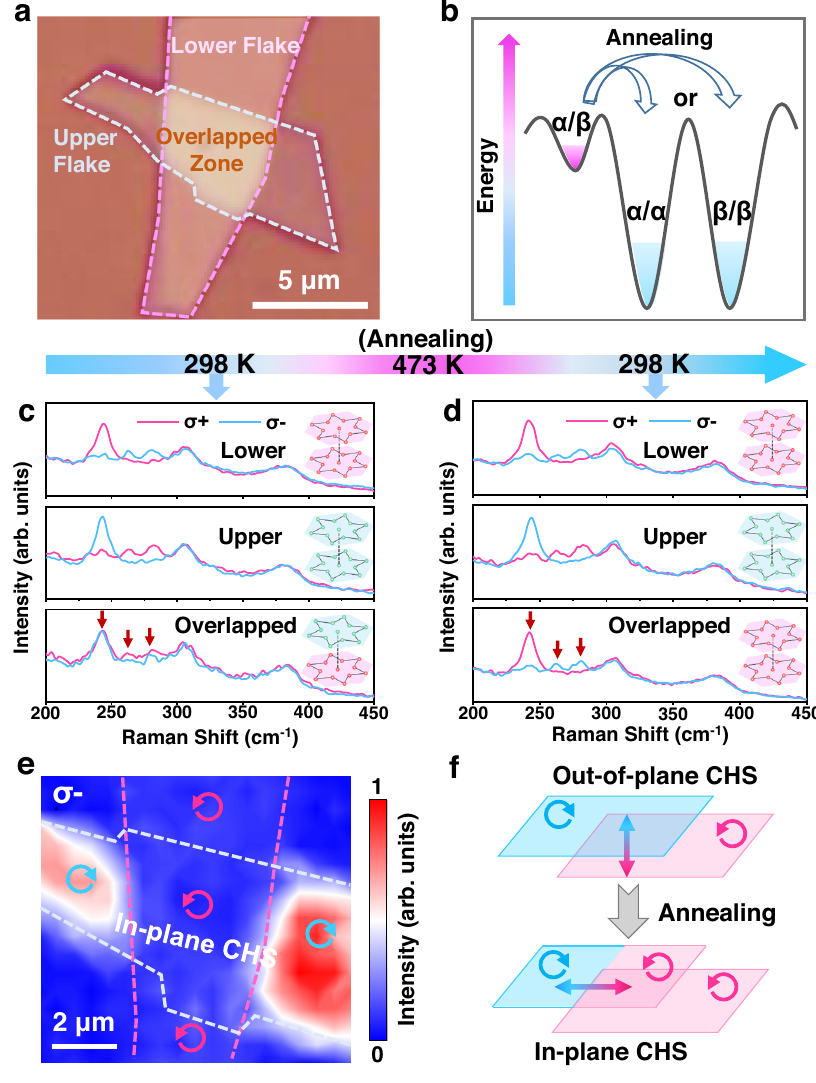
Fig. 5 | Chirality manipulation of the α / β 1T-TaS 2 homostructure. a Optical image of the α / β 1T-TaS 2 homostructure. b Schematic illustration for the trans- formationofthechiralstackingcon fi gurations. c ChiralRamanspectraofthelower fl ake, upper fl ake, and overlapped zone of the initial sample. The insets show the schematic diagrams of the corresponding stacking con fi gurations. Pink and green stars represent oppsite chirality. d Chiral Raman spectra of the sample after annealing(473K,2hours).TheRamanpeaksindicatedbytheredarrowsarethe E g 5 ,